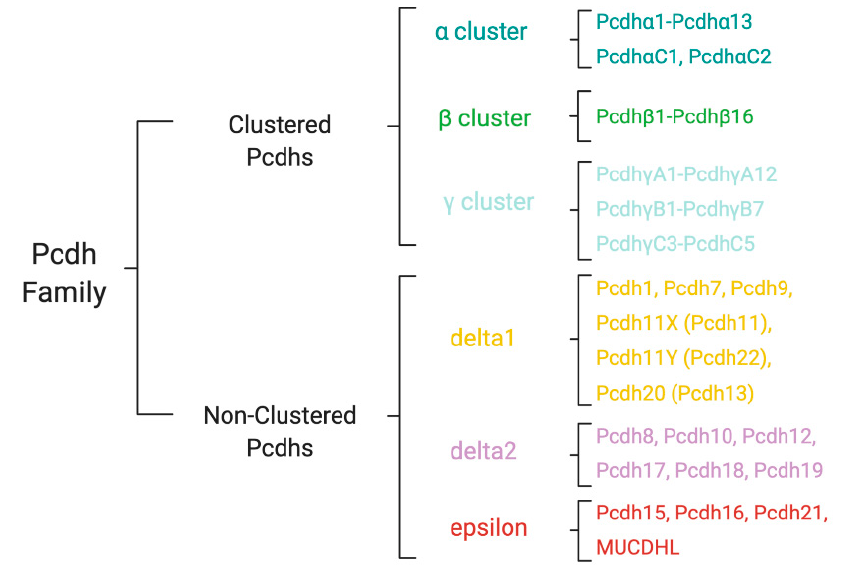
Figure 3. Classification of human protocadherin (PCDH) family. The members of PCDH family are organized in Clustered (alpha, beta, and gamma subfamilies) and Non-Clustered (delta1 and delta2) PCDHs. The Non-Clustered PCDH subfamily also includes PCDHs of the epsilon group.